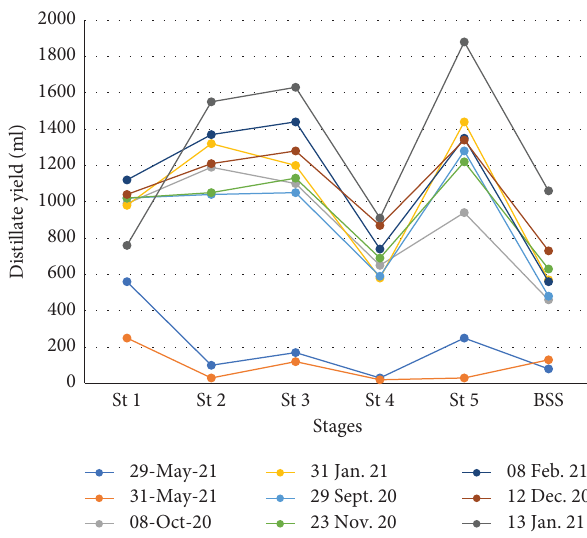
Figure 15: Year-round distillate yield trends.